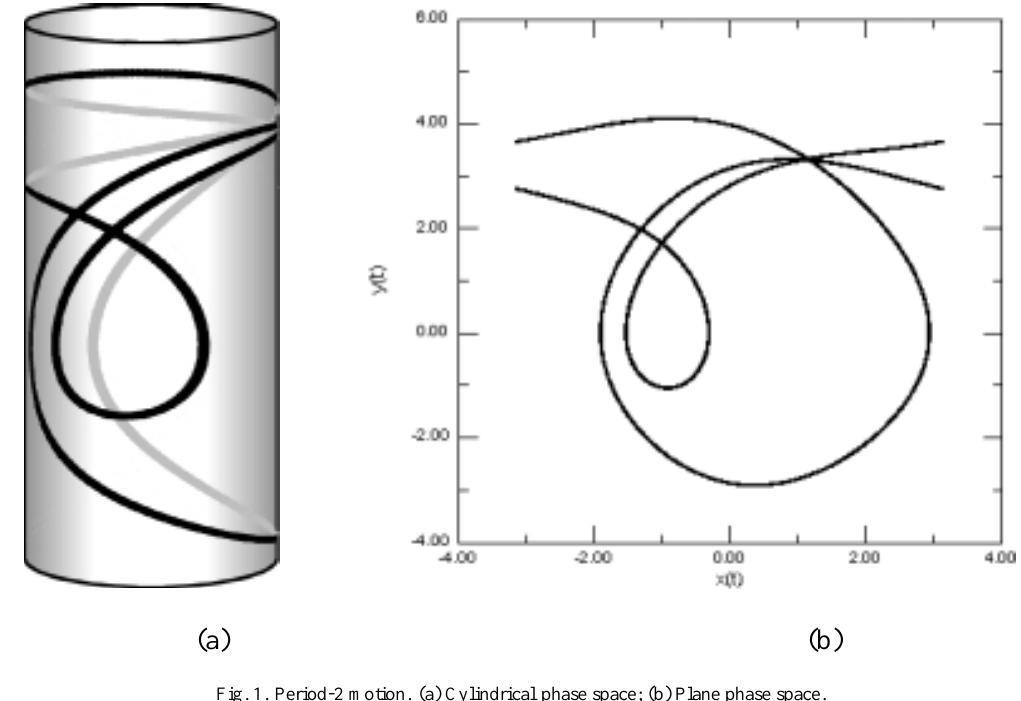
Fig. 1. Period-2 motion. (a) Cylindrical phase space; (b) Plane phase